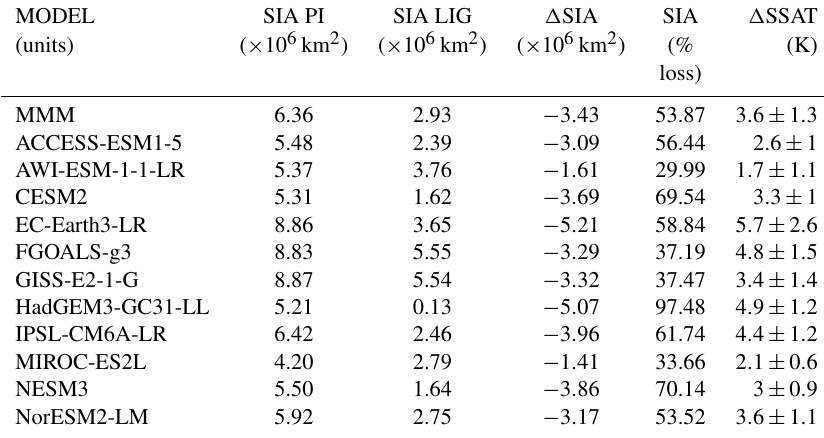
Figure 3. Climatological minimum LIG sea ice concentration maps for each model. Marine core results are from Kageyama et al. (2021): orange outlines indicate that the dating is uncertain; green outlines indicate the data point is from the LIG. The first panel represents the multi-model mean. Table 2. The minimum climatological sea ice area for the PI and the LIG, changes, and the associated (cid:49) SSAT anomalies. Percentage reductions are calculated from PI minimum SIA for each